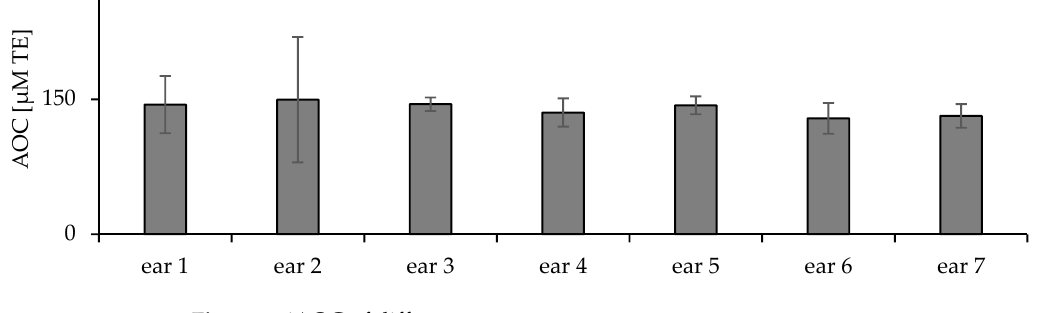
Figure 3. iAOC of different ears.